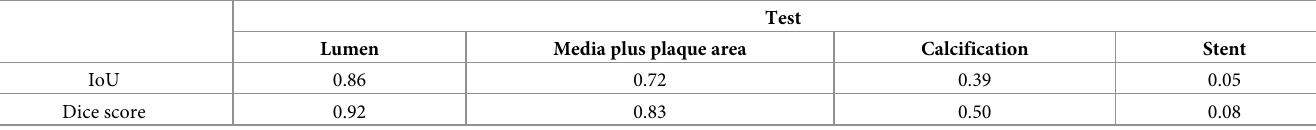
Table 2. Results for stents and each component of the vessels in the test